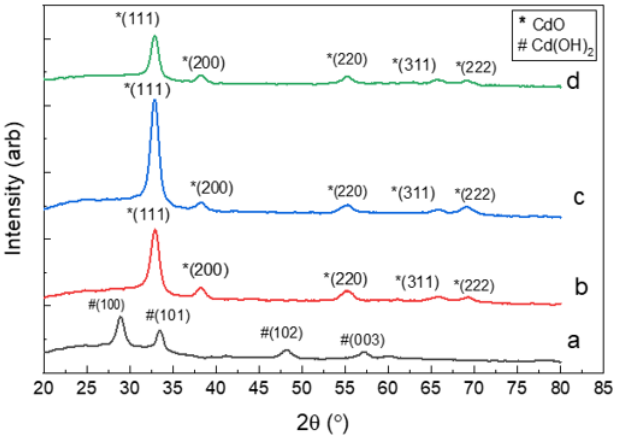
Figure 5. XRD patterns of as-deposited and annealed thin films where t ( a ) = ( b ) 20 min, ( c ) 40 min, and ( d ) 60 min .